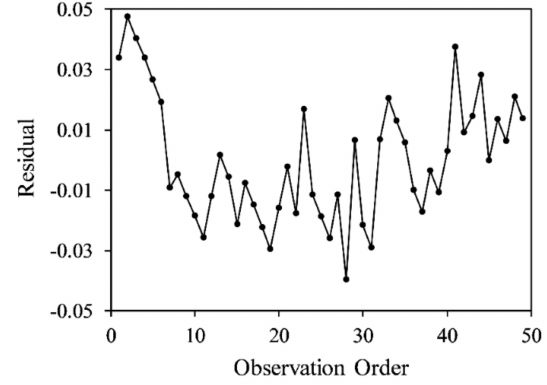
Figure 11. Sequence diagram illustrating that the residuals are not dependent on time. The residuals fluctuate randomly near